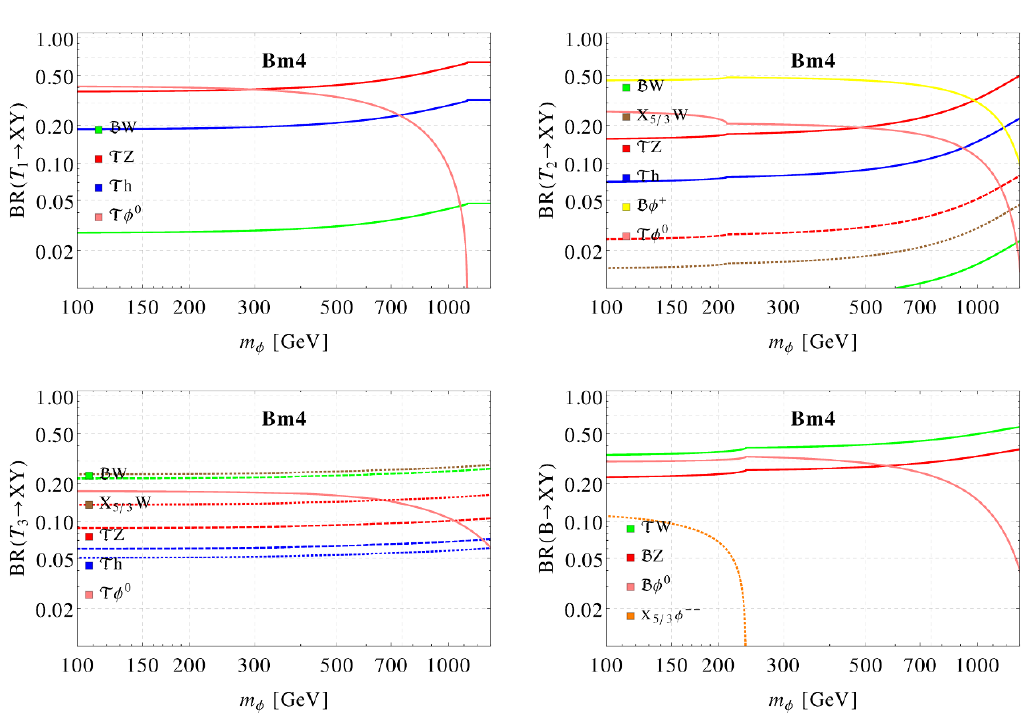
Figure 9 . Branching ratios of T 1 , T 2 , T 3 and B as a function of the common mass of the pNGB triplets m (cid:30) for the benchmark model Bm4 de(cid:12)ned in eqs. (3.24) and (3.25). For simplicity, we assume that all components of the EW triplets have the same mass m (cid:30) . The continuous, dashed and dotted lines correspond respectively to T = f t; T 1 ; T 2 g and B = f b; B g .